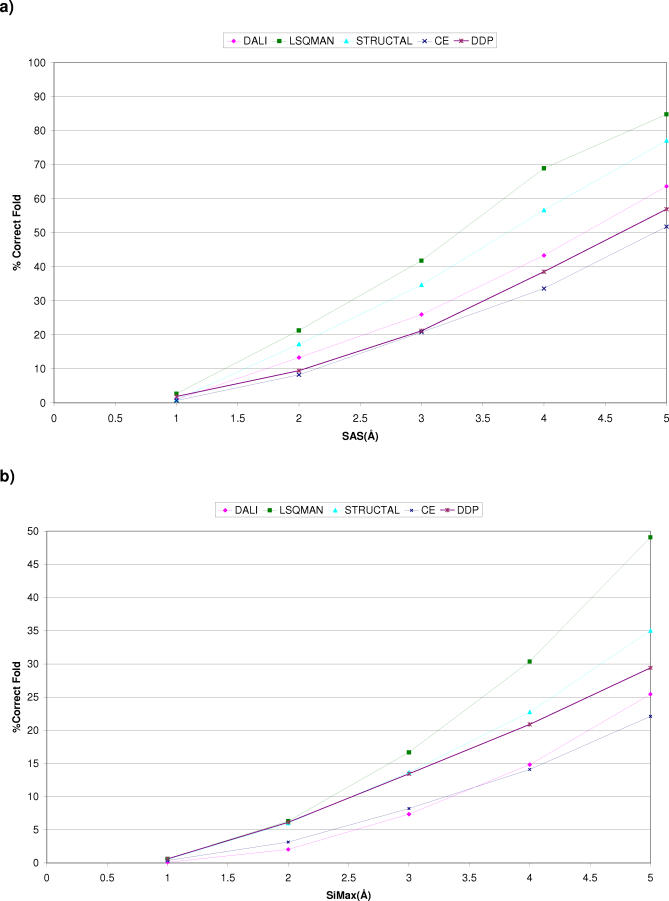
Comparison of Alignment Quality of Domains Adopting the Same CATH Fold Using Two Geometric Scoring Schemes(A) Percentage of correct fold pairs for a given SAS threshold.(B) Percentage of correct fold pairs for a given SiMax threshold.